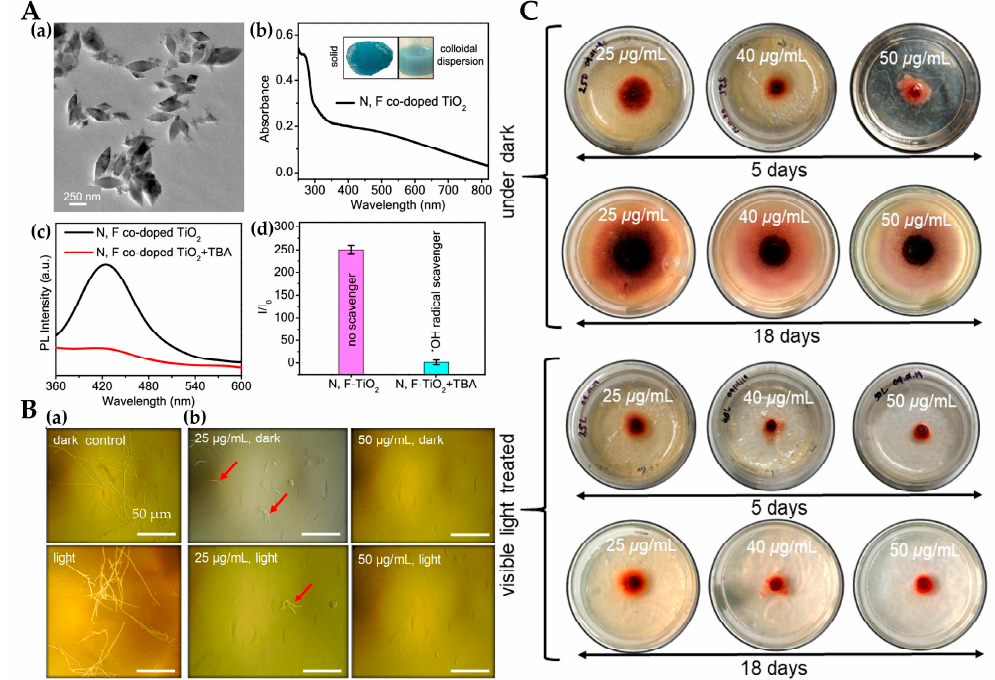
Figure 6. ( A ) TEM image of N, F doped TiO 2 nanoparticles ( a ); UV − vis absorption spectrum of colloidal nanoparticles ( b ); evidence of reactive oxygen species (ROS) generation by nanoparticles under visible-light exposure ( c ); tert-butyl alcohol (TBA) as a · OH scavenger to prove that · OH is the dominant ROS component ( d ); ( B ) microscopic imaging of Fusarium oxysporum spore germination under different conditions. Red arrows indicate fungal spores. ( C ) Images of fungal colonies [65].